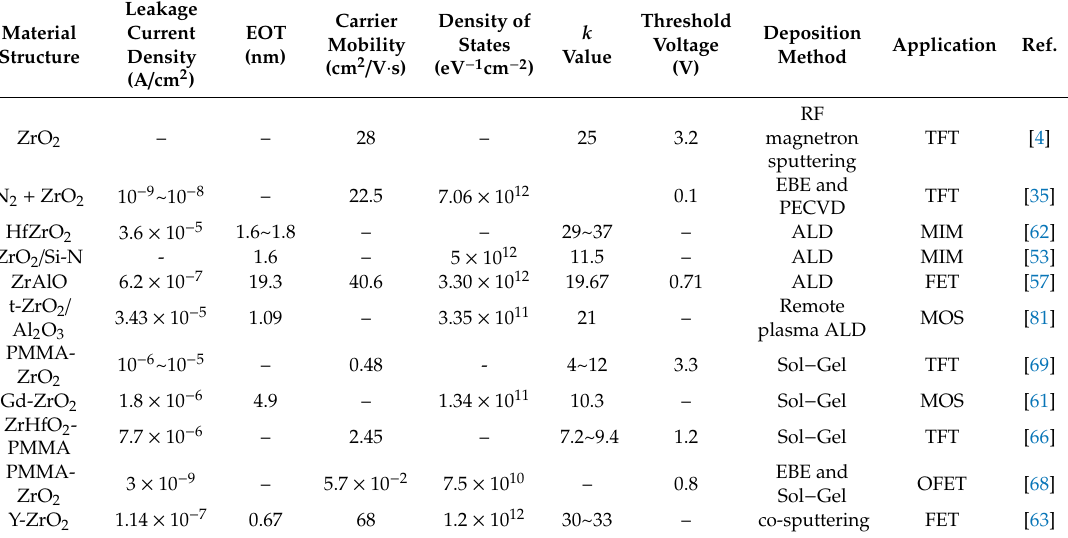
Table 1. Comparison of relevant properties of ZrO 2 and its composite